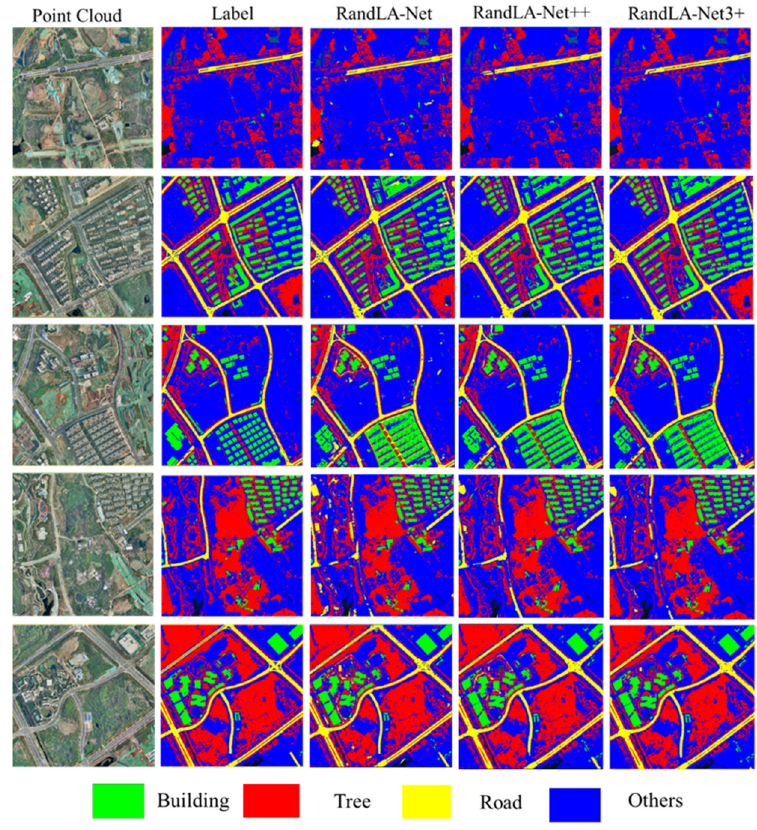
Remote Sens. 2022 , 14 , x FOR PEER REVIEW Figure 8. Point cloud semantic segmentation results. Figure 8. Point cloud semantic segmentation results.